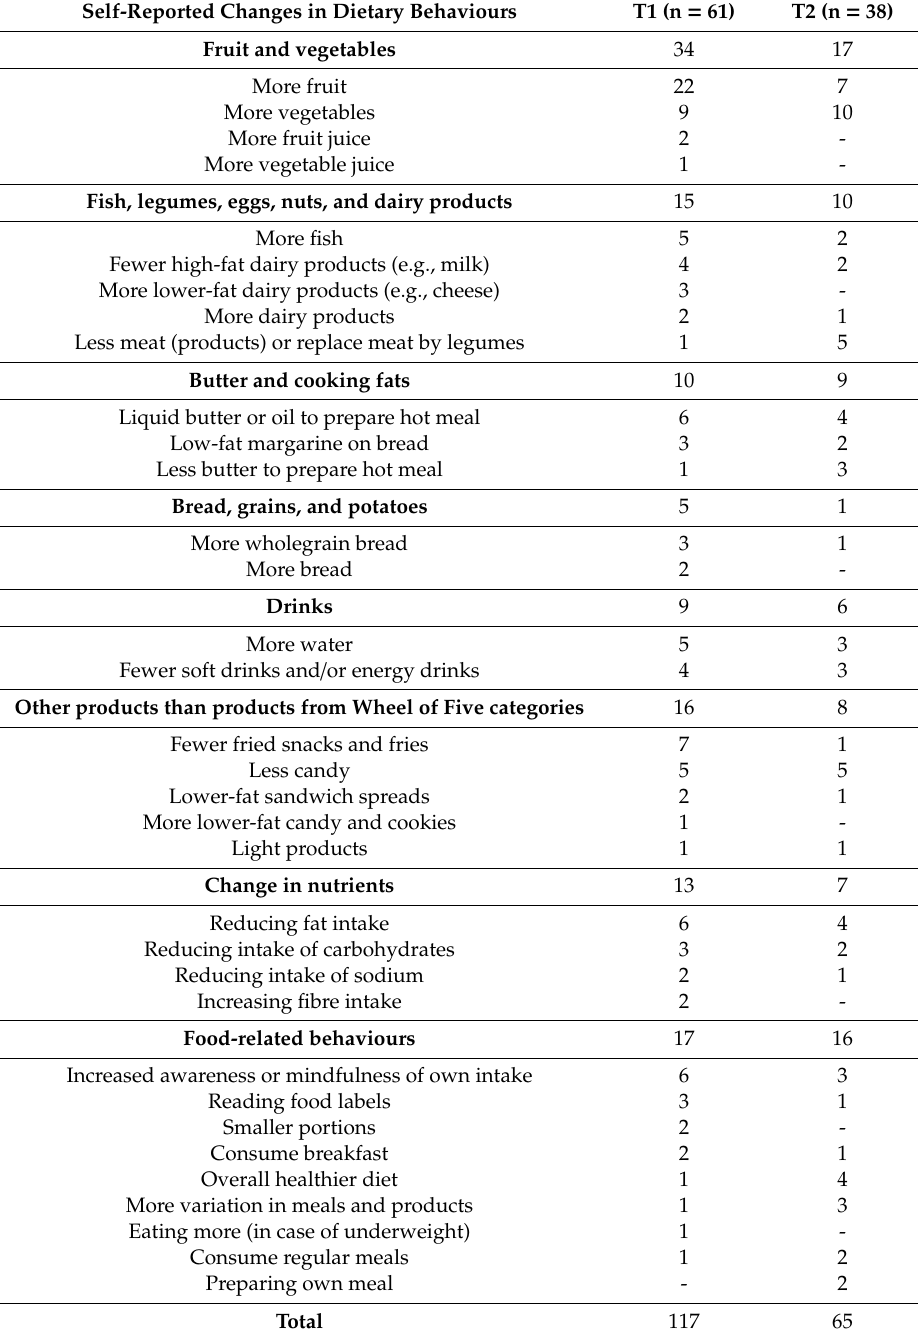
Table 4. Self-reported changes in dietary behaviours in the intervention group at post-test (T1; n = 108) and follow-up (T2; n =